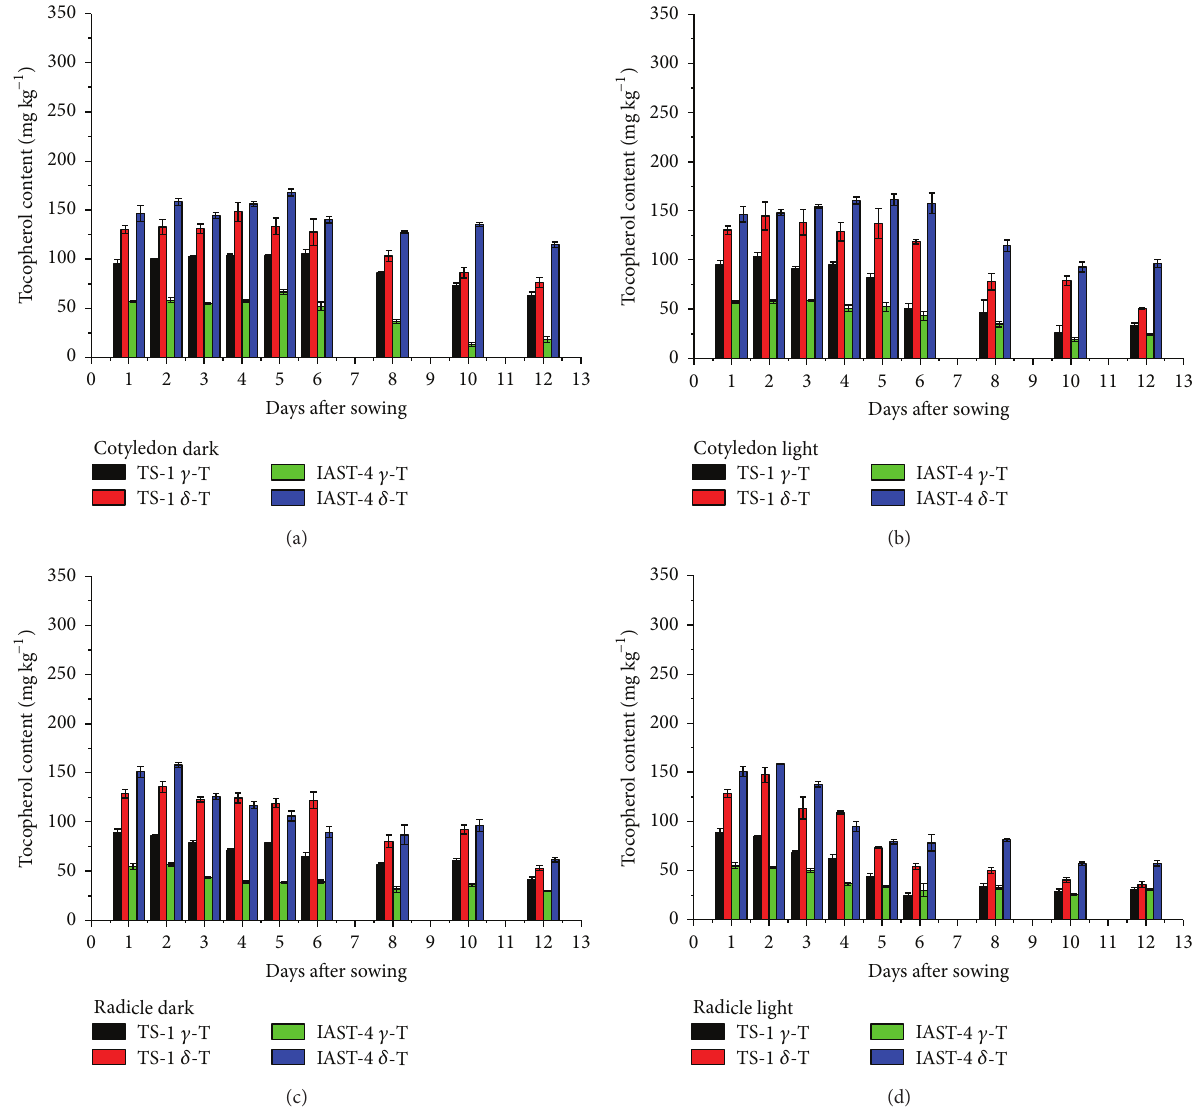
Figure 7: 𝛾 - and 𝛿 -tocopherol contents (mgkg −1 dry tissue) from 1 to 12 days after sowing in cotyledons and radicles of sunflower lines TS-1 and IAST-4, with different increased levels of 𝛾 - and 𝛿 -tocopherol, from seedlings grown under dark and light conditions. Data are presented as mean ± standard error of three